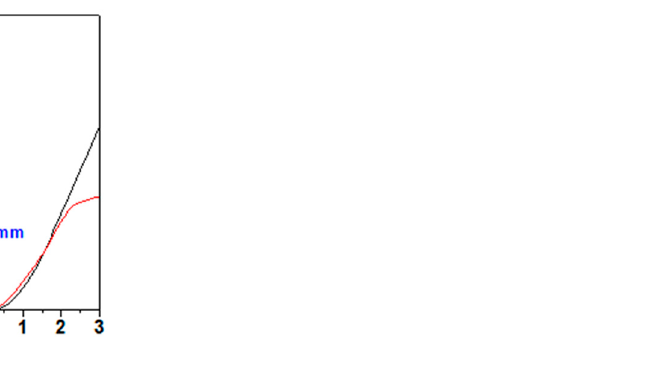
Figure 6. The characteristic of light output power versus I D measured on LE-HEMTs on two epitaxy structures.